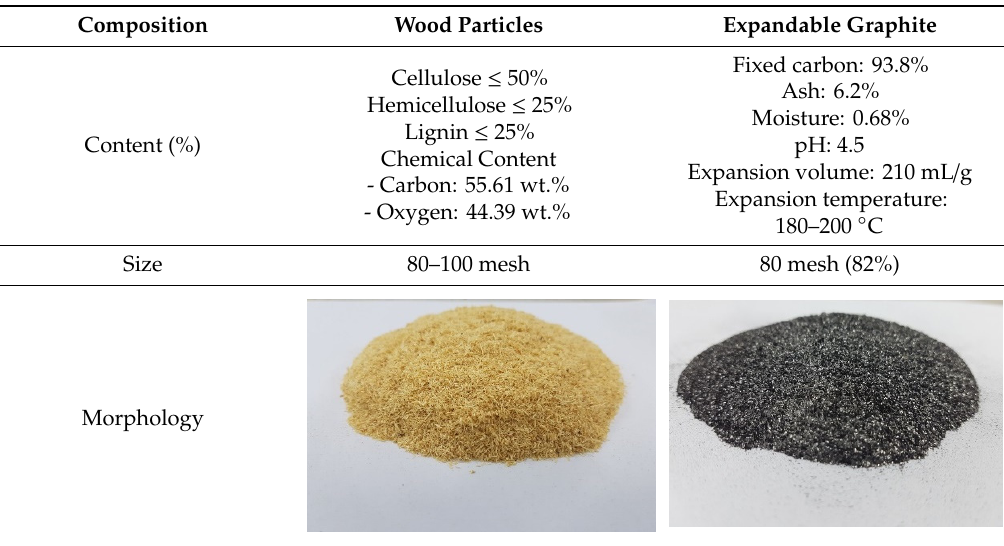
Table 1. Compositions and morphologies of wood particles and expandable graphite.